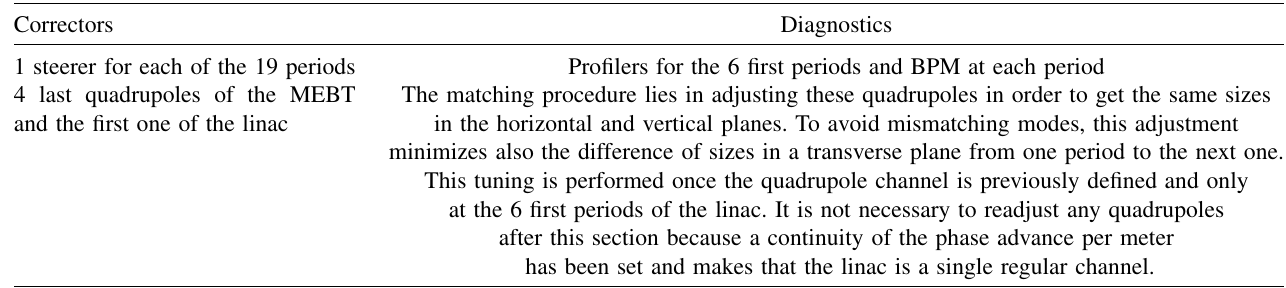
TABLE IV. The correction scheme of the superconducting linac.